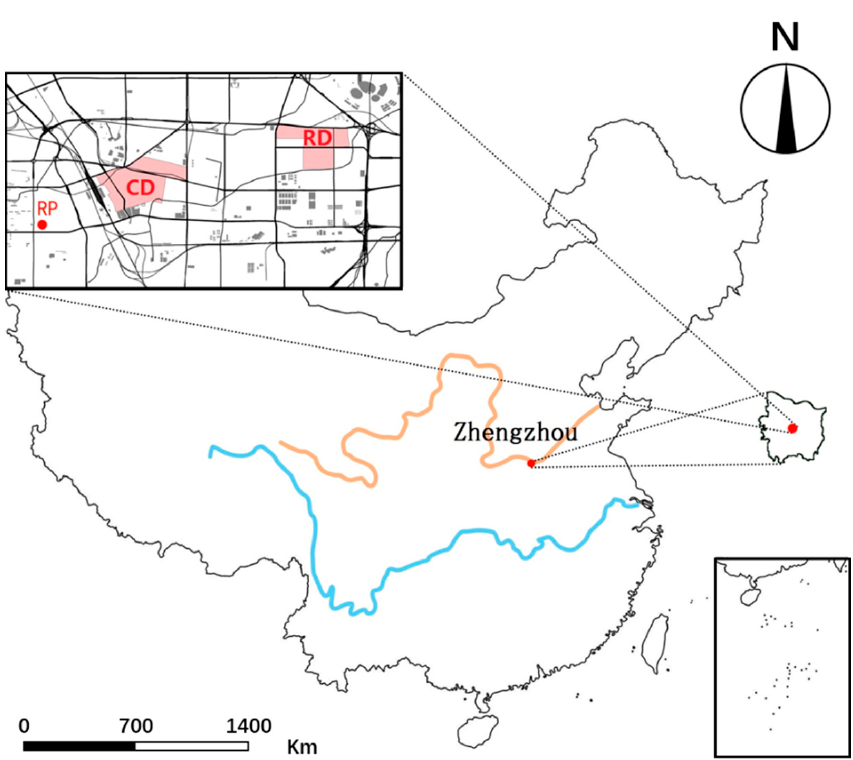
Figure 1. Locations of Zhengzhou city, sampling commercial district (CD), residential district (RD), and reference point (RP).